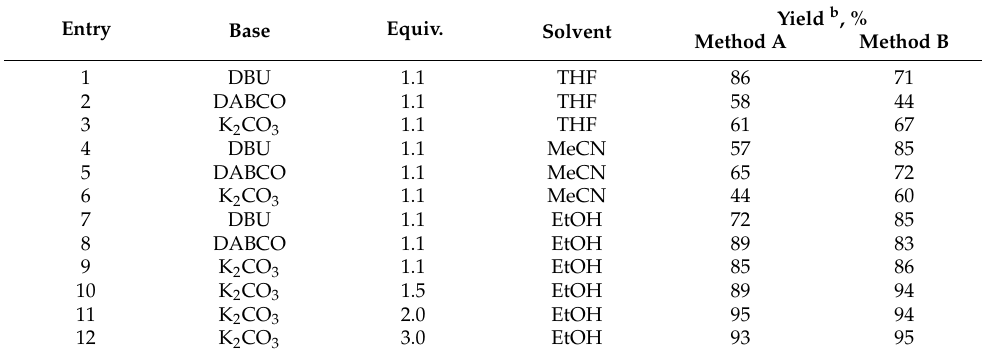
EtOH 95 K 2 CO 3 3.0 EtOH